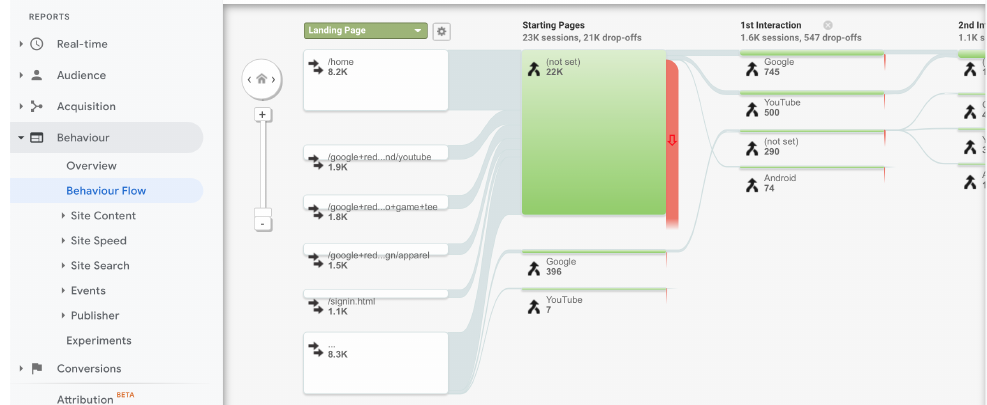
Figure 2. Example of the “Behavior flow” report in Google Analytics. It shows the sequence of most visited pages, from left to right. The thick red lines indicate traffic drop-offs. Each column corresponds to a web page or event. Therefore, this type of visualization does not show all the navigation in a single view but continues to the right, according to the number of pages or